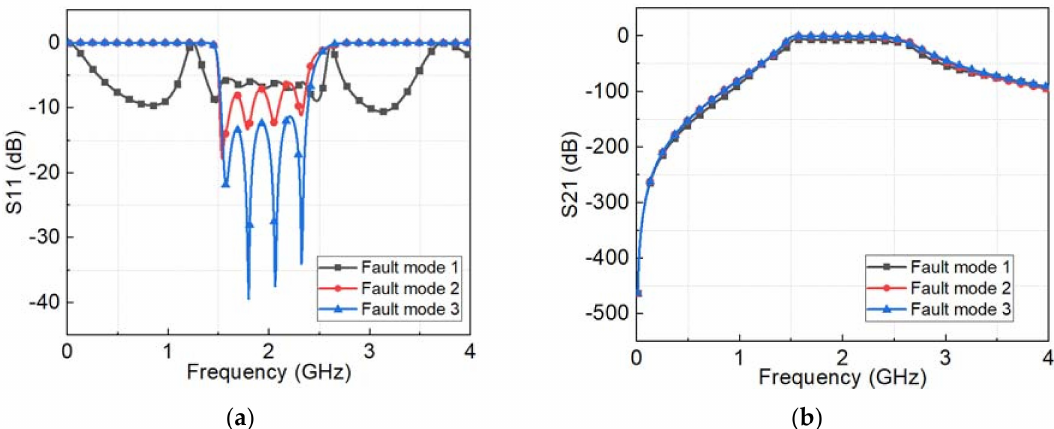
Figure 14. S-parameters of the filter circuit with fault. For fault mode 1, R 1 = 100 Ω , C 1 = 0.15 pF. For fault mode 2, L 2 = 3 nH. For fault mode 3, R 3 = 104 m Ω , L 3 = 0.036 nH and C 3 = 0.022 pF. ( a ) S 11 , ( b ) S 21